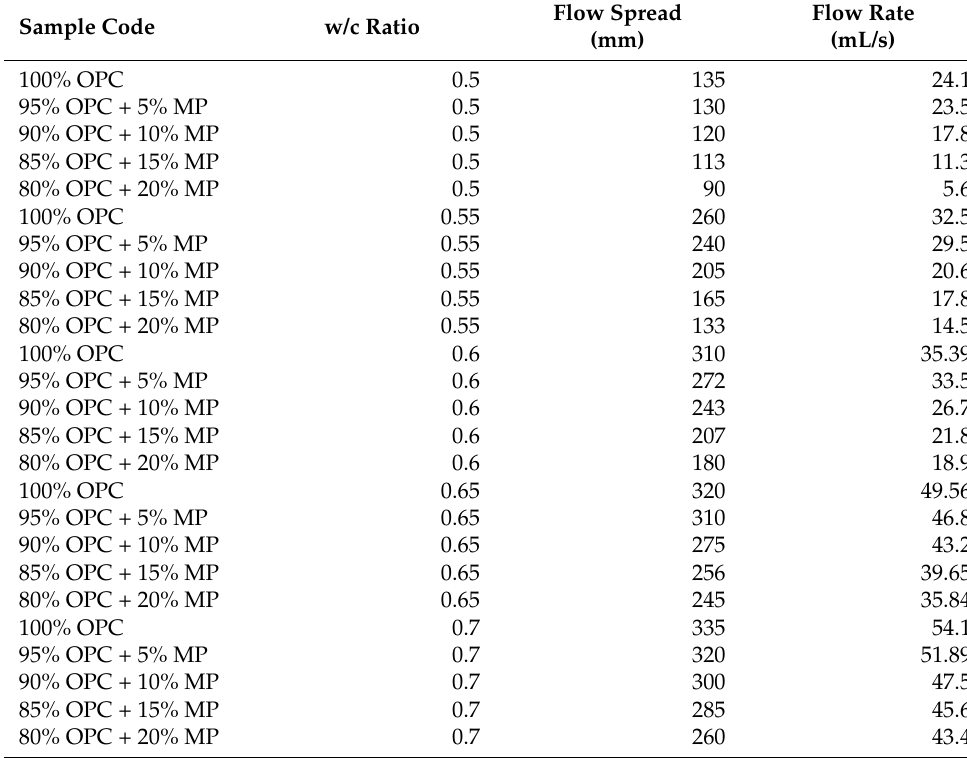
Table 2. Variation of flow rate and flow spread with W/CM at various MP